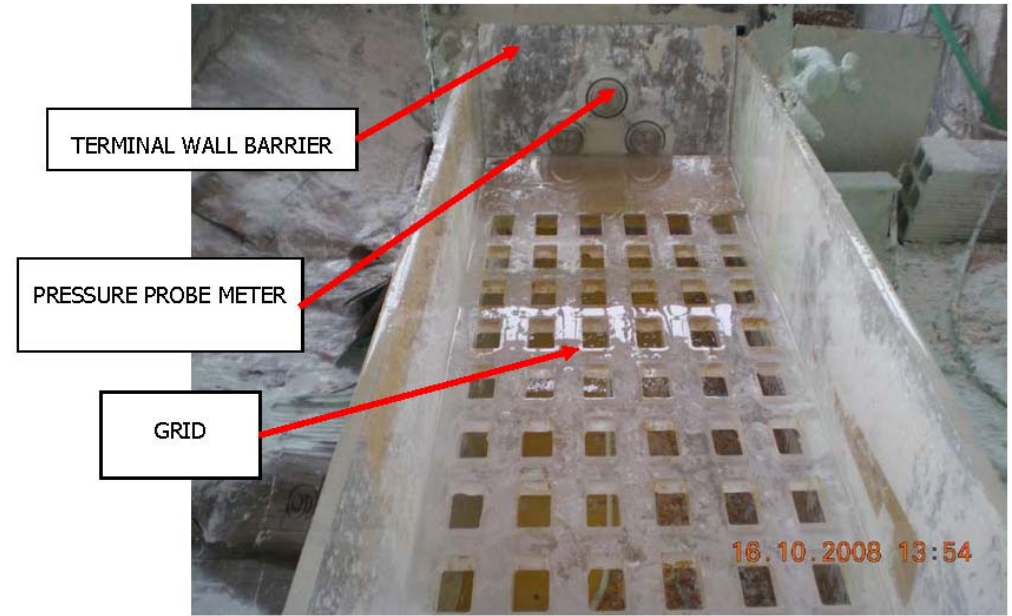
Figure 3. Analyzed bottom grid